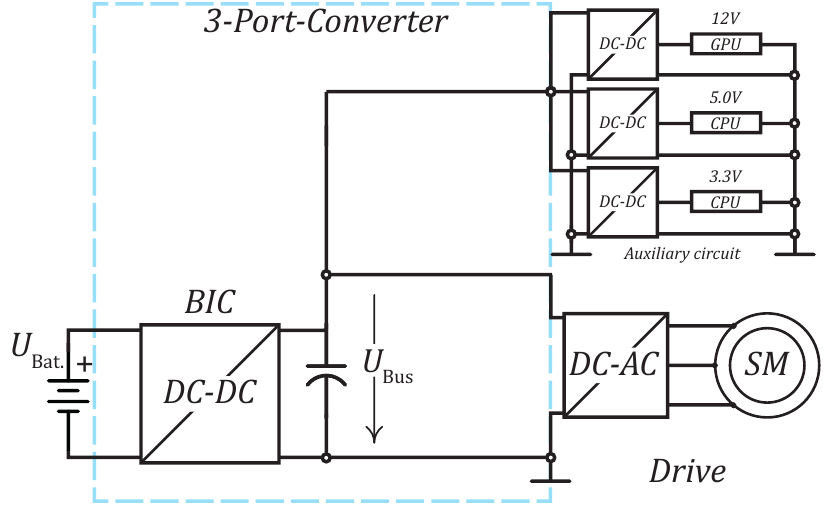
Figure 7. Topology III: Interface converter between the battery and auxiliary